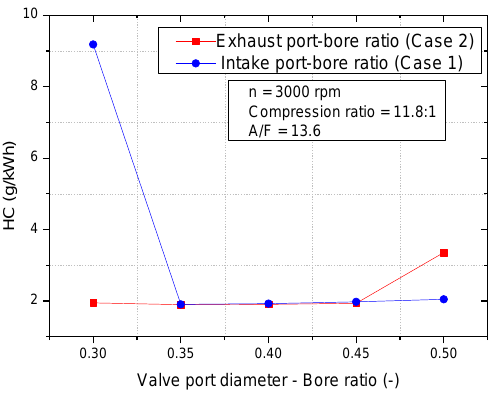
Figure 21. HC emission versus VPD/B.